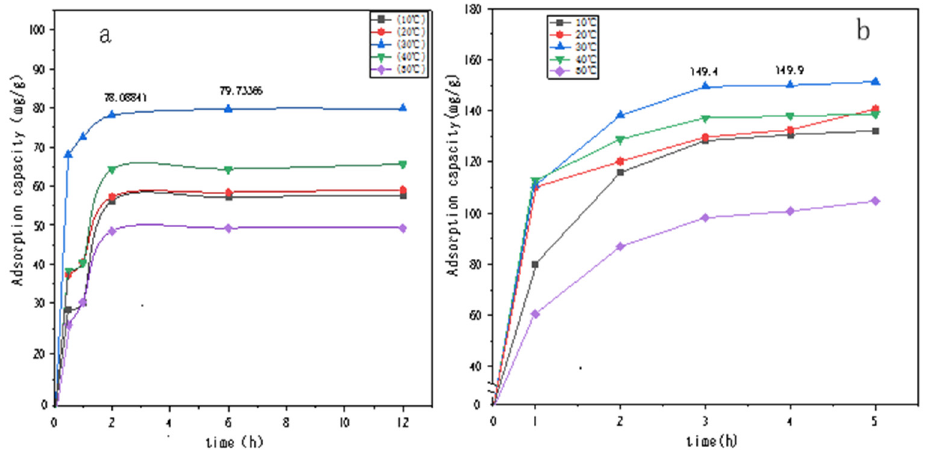
Figure 9. Effect that temperature and adsorption time have on the adsorption of ( a ) MO and ( b ) CR dye solutions by PLLA/CS–GO. mg/g refers to the mass (mg) of pollutants removed by the fiber composite material per unit mass (g).